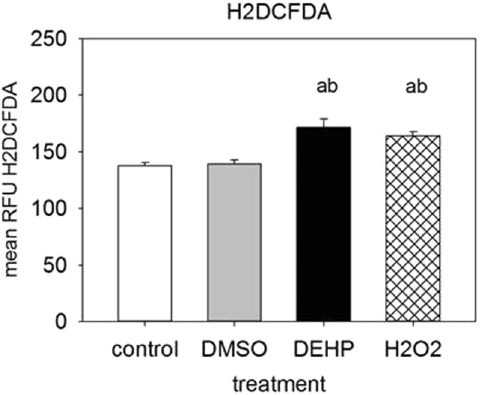
Figure 2. Analysis of ROS-production after DEHP-exposure: SGBS cells were exposed to DEHP from d0–d4 and subsequently differentiated into adipocytes. For the ROS-measurement (A), the medium was changed to DMEM/F12 with 10 µ M H2DCFDA at d4 and incubated for 30 min. As the positive assay control H 2 O 2 (25 µ M) was used, as well as an untreated control. Statistics: a = DEHP/H 2 O 2 versus control; b = DEHP/H 2 O 2 versus DMSO control; ANOVA (Student-Newman-Keuls Method); N = 2, n = 9.